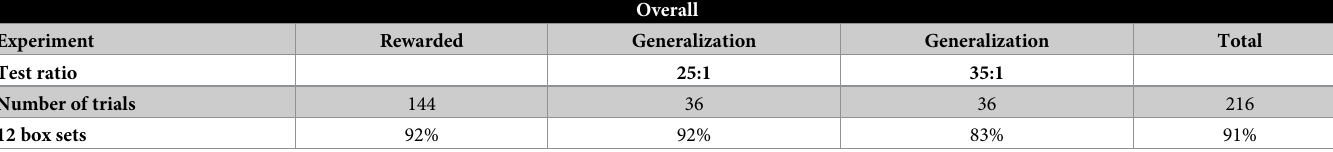
Table 3. Testing sessions including generalization trials of in-between ratios of acetoin: Octenol reflecting AIV infected individuals.